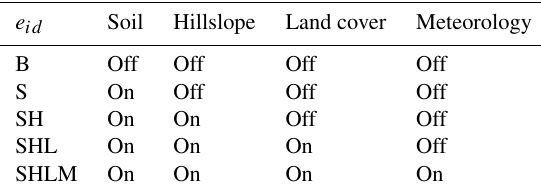
Table 2. Through a series of model experiments, the heterogeneity of model parameters and forcing data is turned on (heterogeneous) and off (homogeneous). For simplicity, the parameters and forcing data are grouped into soil, hillslope, land cover, and meteorology